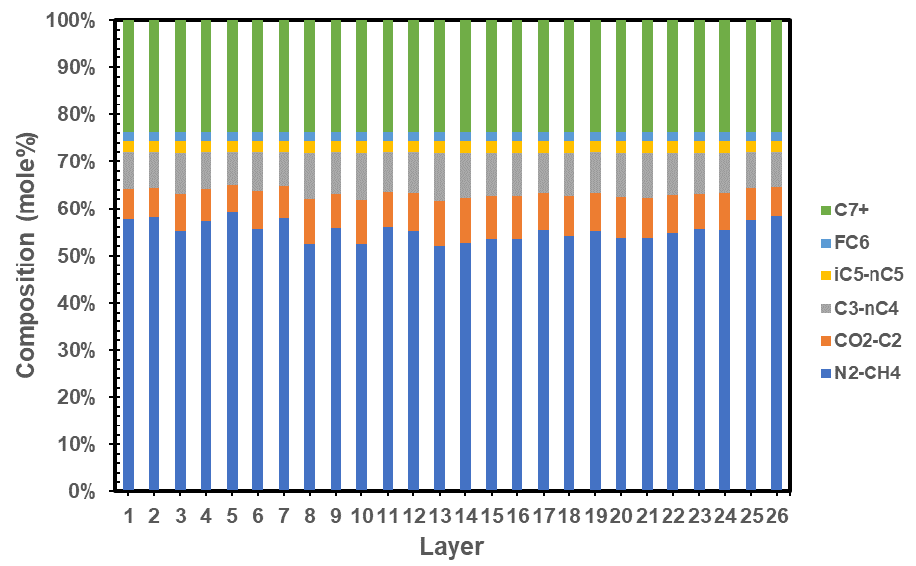
Figure 5. Fluid composition variation by layer in the reservoir. The top layer in the model is Layer 1. The impact of fluid composition variation with depth on the produced gas composition is controlled by the fracture height extension.